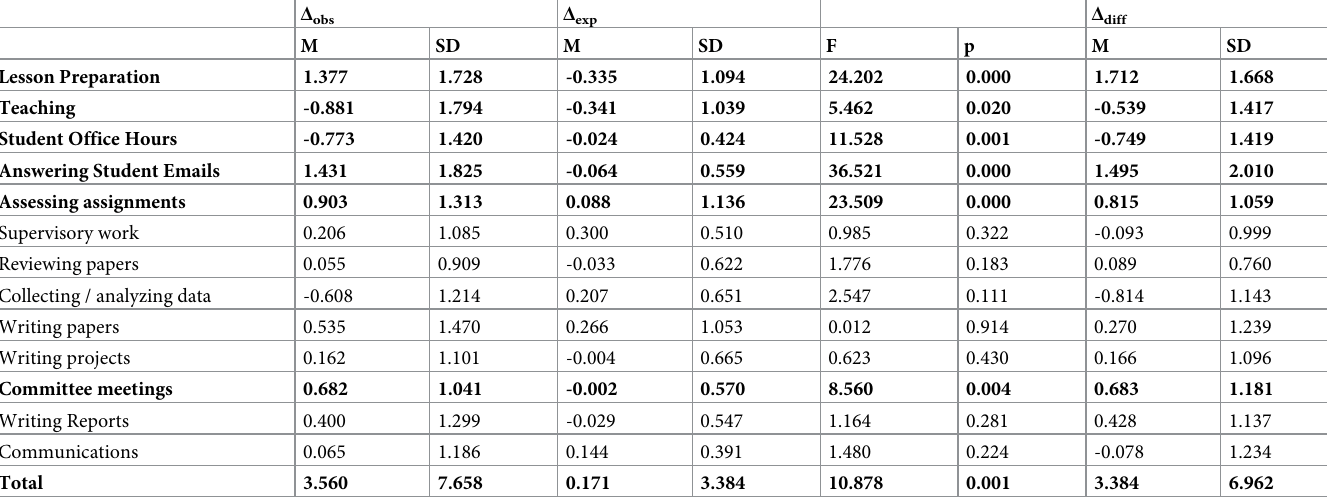
Table 3. Comparison of observed and expected changes in working hours, comparing the first wave time period to the pre-pandemic